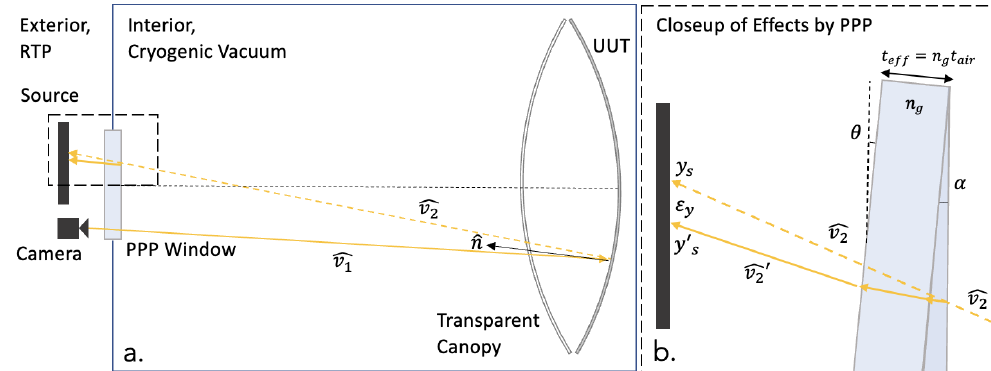
Figure 4. We examine the effects of a plane window between a room temperature and pressure environment (RTP) and a cryogenic vacuum ( a ). A camera focuses through the plate and transparent Mylar canopy to the reflective Mylar surface. The circular meniscus window is 254 mm in diameter, while the full UUT aperture is 1 m. Rays from the UUT generally intercept the plate at non-normal incidence and introduce transverse displacement deviation 𝜀 𝑦 as a function of ray slope 𝑣 2 ̂ . The ray slope 𝑣 2 ̂′ ≠ 𝑣 2 ̂ for any PPP tilt, 𝜃 , and wedge, 𝛼 , as seen in ( b ). In absence of the plate, the screen y-intercept position would be 𝑦 𝑠 , rather than the plate-displaced 𝑦′ 𝑠 . The ray path from the camera to the UUT is also deviated by the plate, but its detail is not highlighted in this schematic.